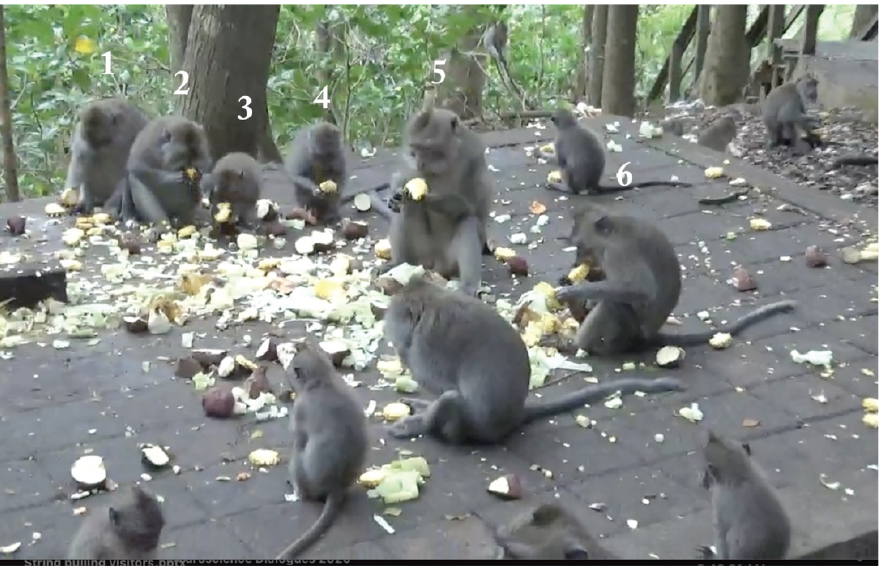
Members of a Group of Macaca fascicularis Eating Corn at a Provisioning